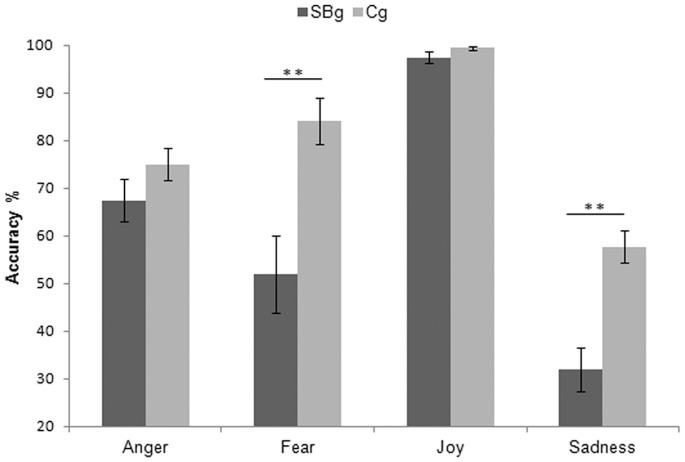
Accuracy Rate.Accuracy rate for Street-Boys group (SBg) and Control group (Cg). ** = p<0.005. Only differences between groups were showed. See the text for differences inside each group. Error bars are SE.